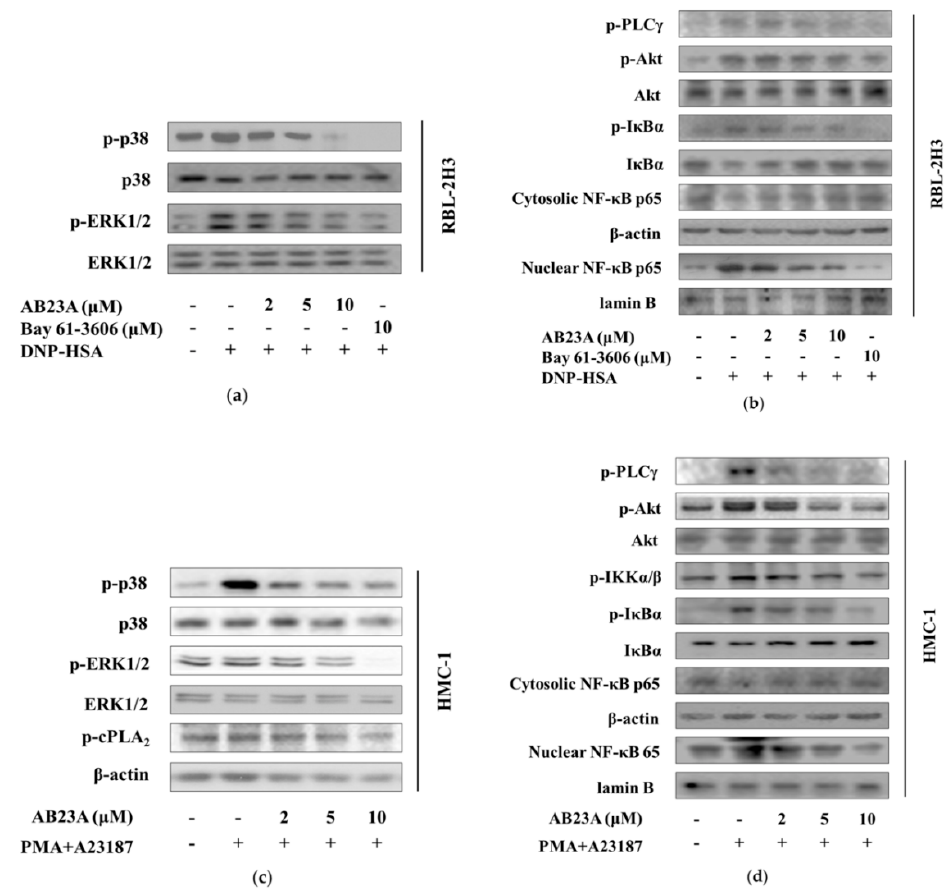
Figure 5. AB23A attenuates the phosphorylation of the IgE/Ag or phorbol 12-myristate 13-acetate (PMA)/A23187-stimulated signaling pathway in RBL-2H3 cells and HMC-1. ( a , b ) IgE-sensitized RBL-2H3 cells were pre-incubated with AB23A or Bay 61-3606 for 1 h, then stimulated with DNP-HSA for 15 min. Cell lysates were immunoblotted for p-p38, p-ERK1/2, p-PLC γ , p-Akt, p-I κ B α , I κ B α , and cytosolic and nuclear NF- κ B p65. ( c , d ) HMC-1 cells were pre-treated with AB23A for 24 h, then stimulated with PMA plus A23187 for 20 min. Cell lysates were immunoblotted for p-p38, p-ERK1/2, p-cPLA2, p-PLC γ , p-Akt, p-IKK α / β , p-I κ B α , I κ B α , and cytosolic and nuclear NF- κ B p65.